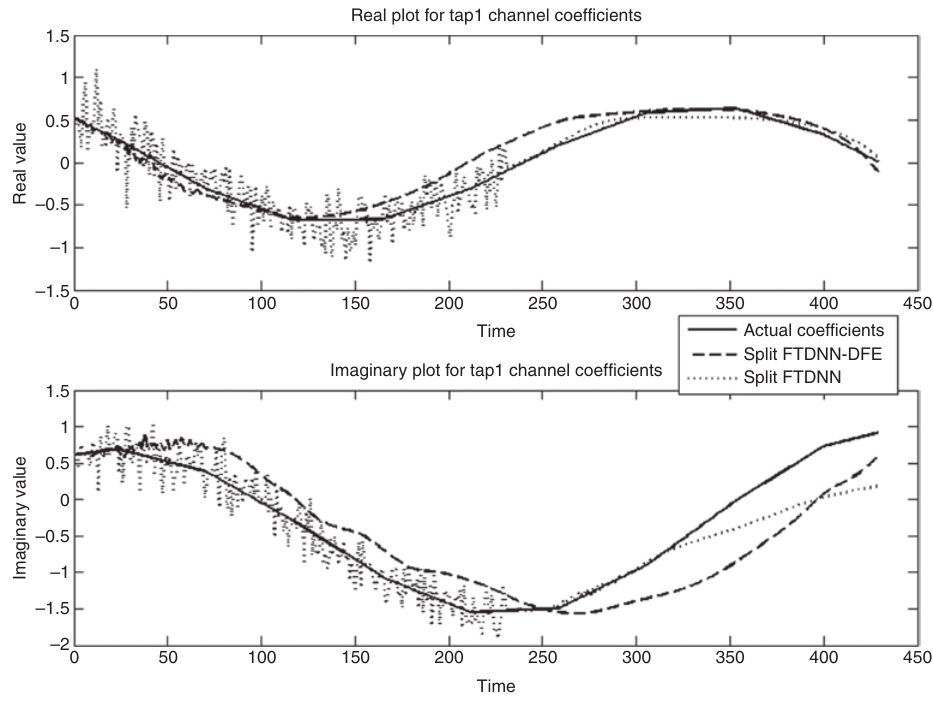
Figure 11: Channel Gain Plot for Case 2.